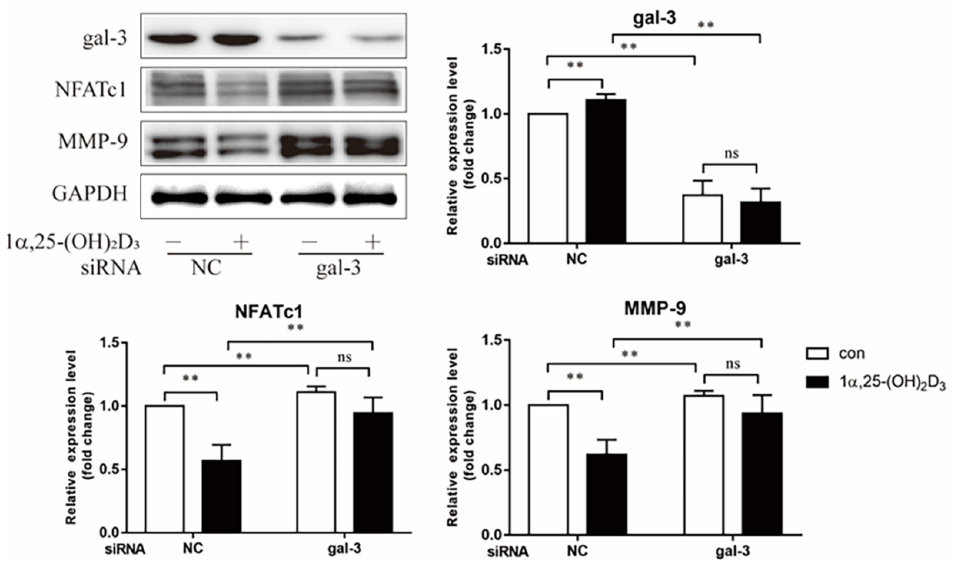
Figure 7. Gal-3 knockdown attenuated the inhibitory effect of 1 α ,25-(OH) 2 D 3 on OC-related protein expression. The histograms show the relative expression level of proteins. Data are shown as means ± SD. n =3, ** p < 0.01, ns means p > 0.05.